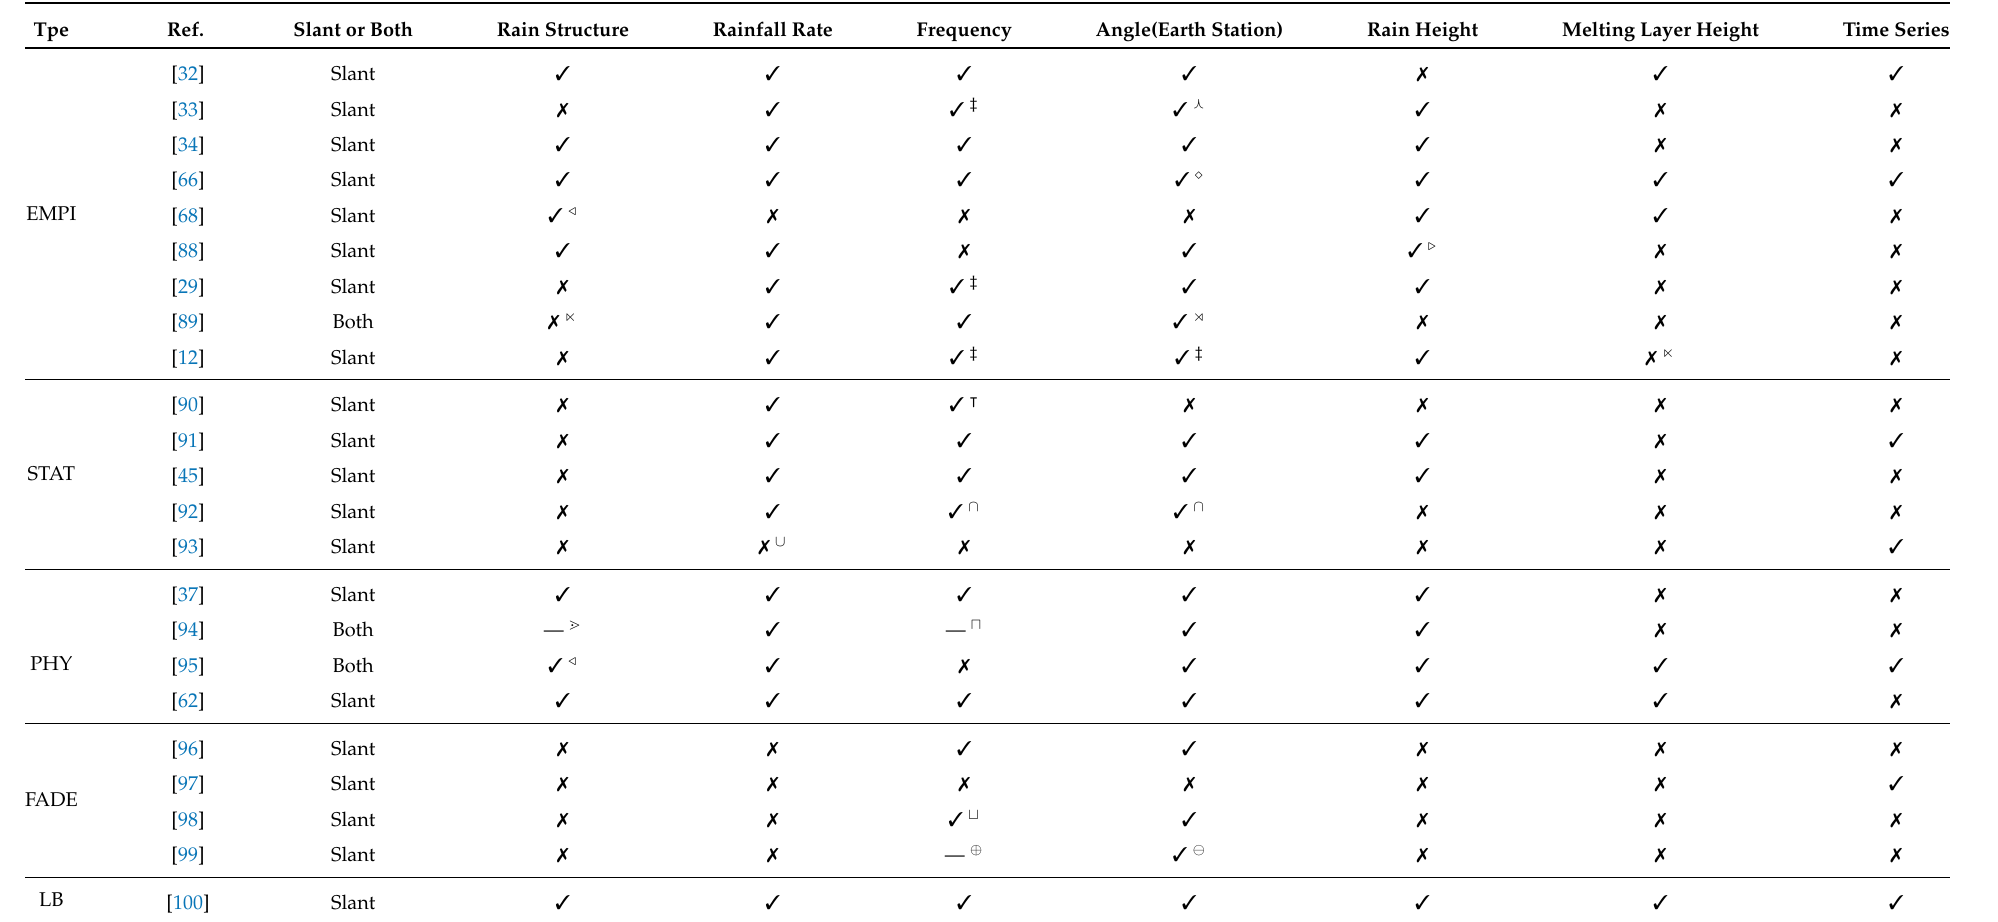
Table 7. Characteristics